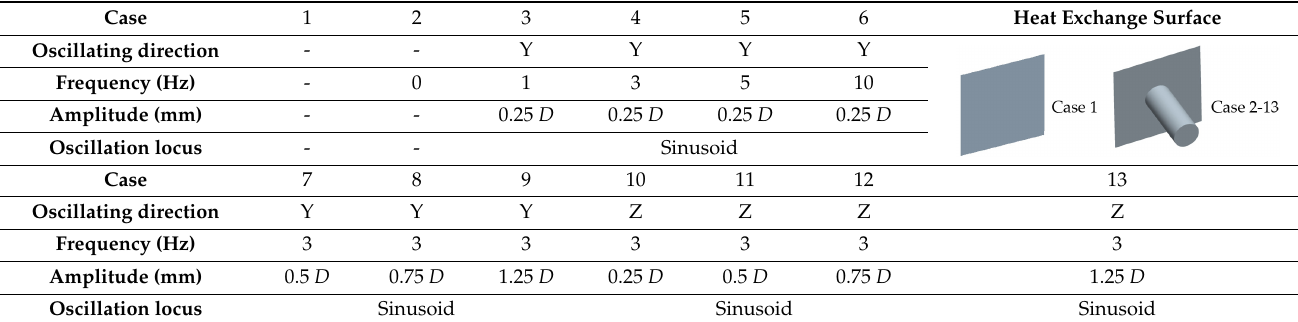
Table 3. Simulation parameters for different cases.